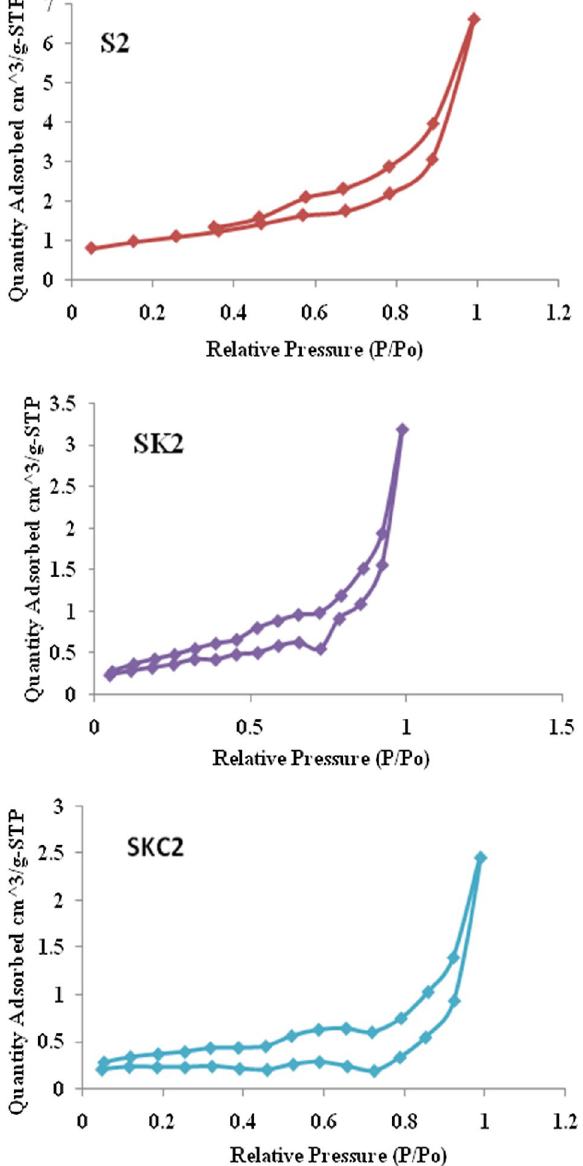
Fig. 2 N 2 adsorption–desorption isotherms for the samples S2, SK2, and